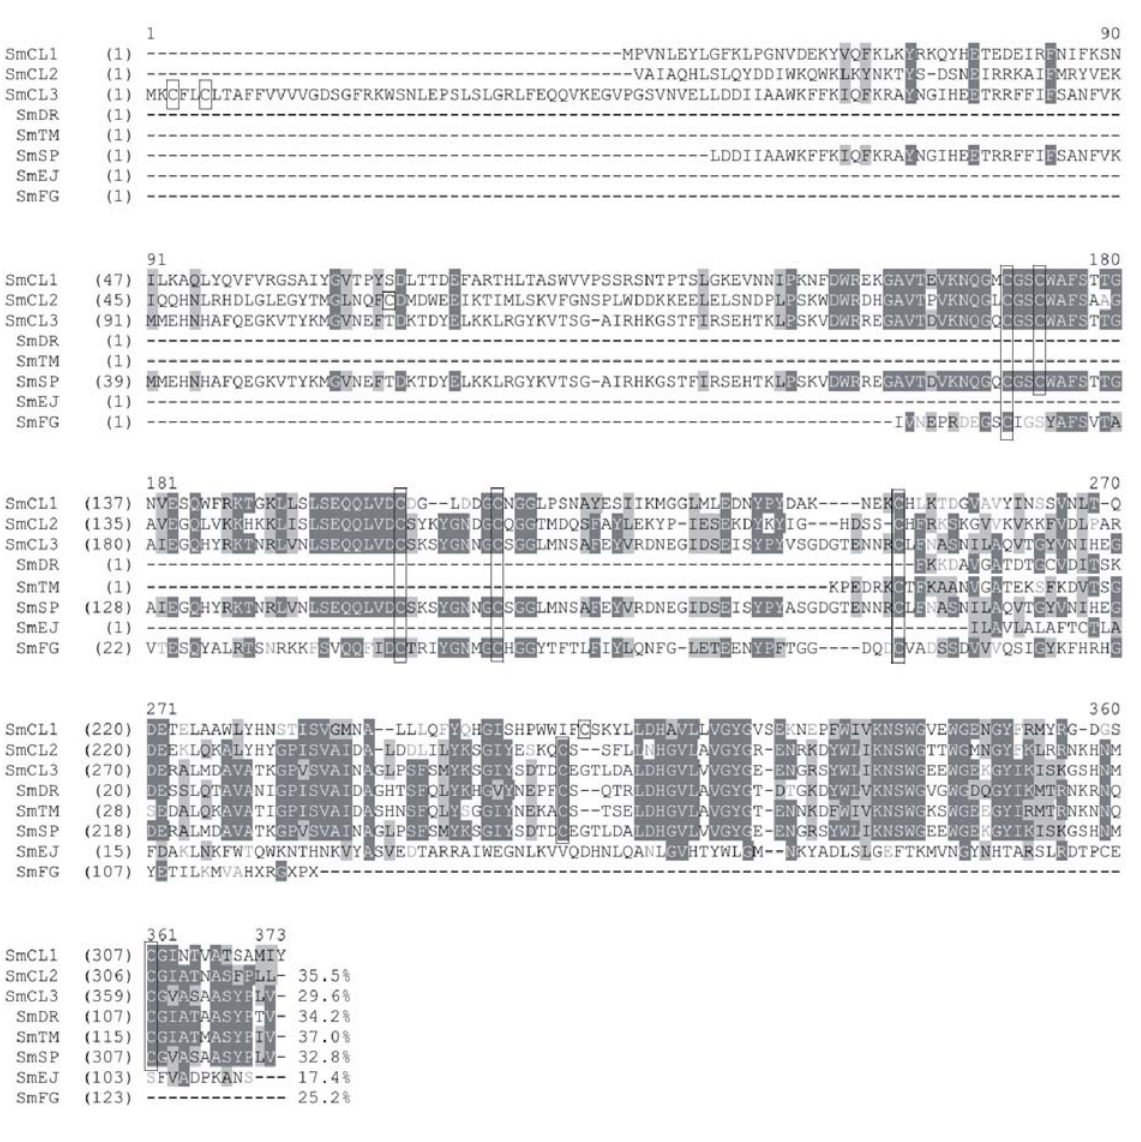
Figure 4. Alignment of amino acid sequences of new potential cathepsin L family identified from Schistosoma mansoni transcriptome. The comparison was made in regions